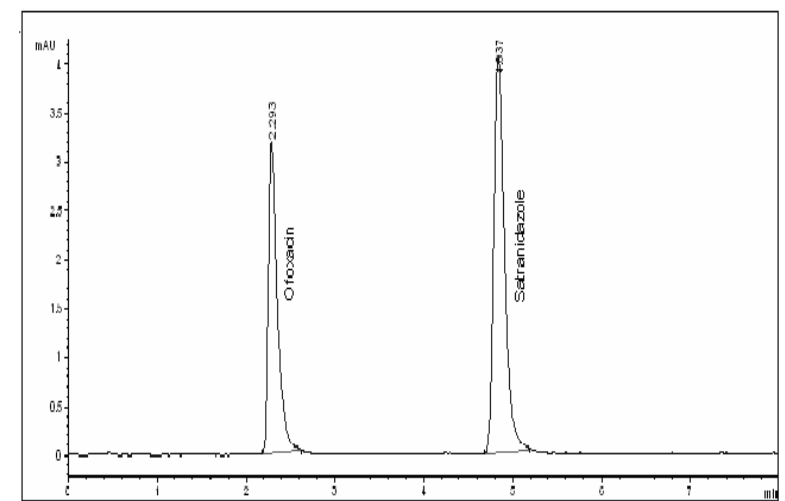
Figure 1. Typical HPLC chromatogram showing ofloxacin (2 µg/mL) and satranidazole (3 µg/mL). Assay